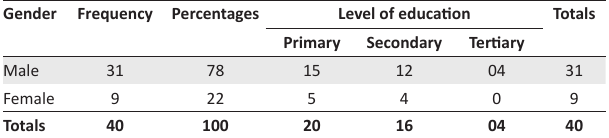
TABLE 1: Breakdown of respondents according to gender and level of education ( N =